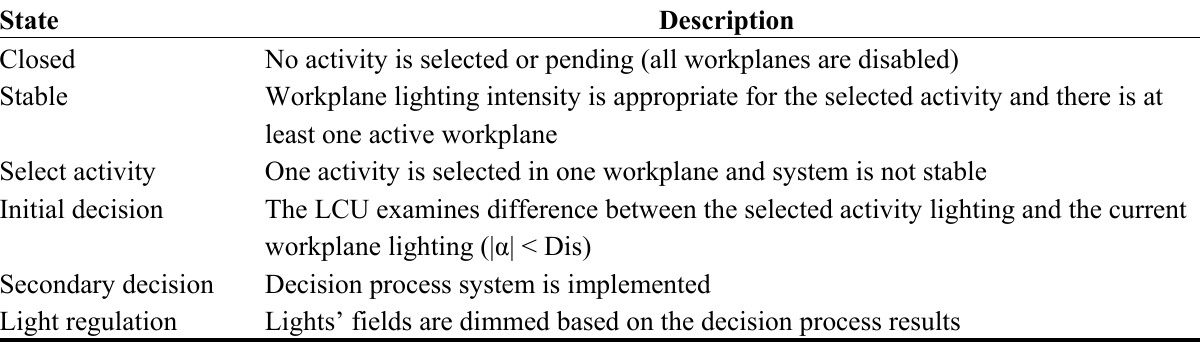
Table 1. Lighting control